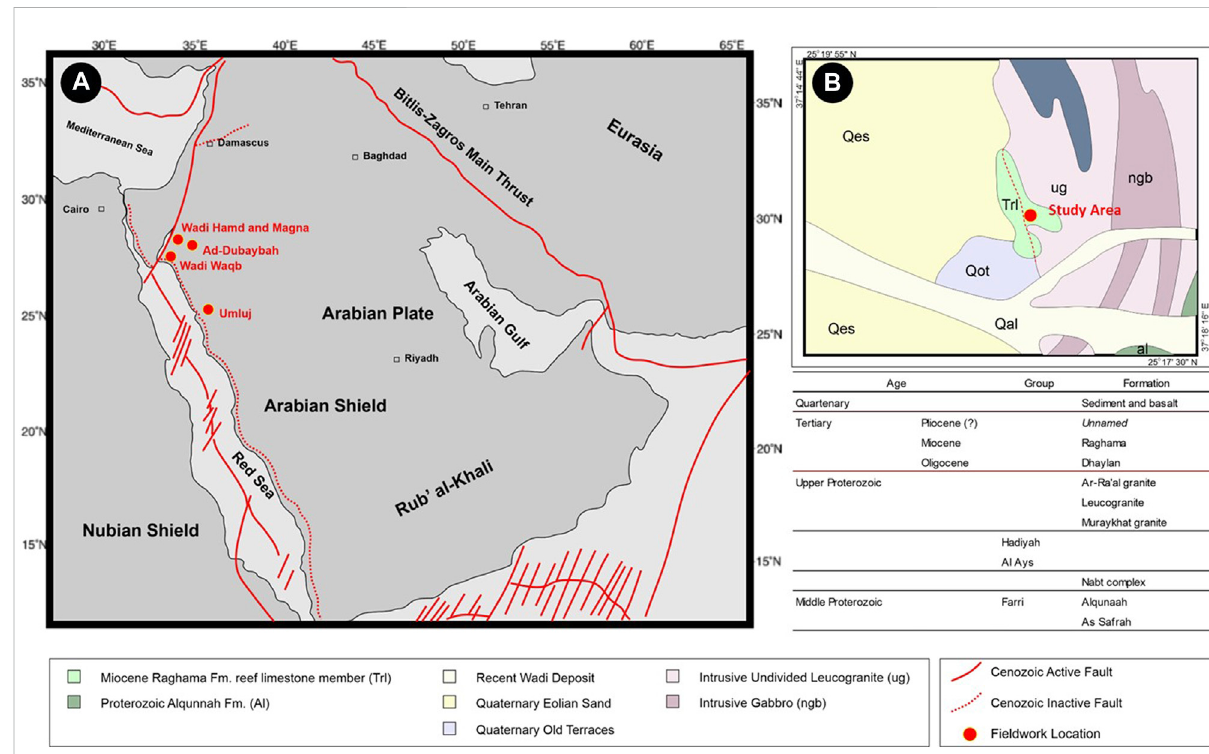
FIGURE 1 Map of the study area. (A) Regional tectonic of the Saudi Arabian Plate. The red dots are Umm Luj ’ s recent study area and three previous study areas:Wadi HamdandMagna,Ad-Dubaybah,andWadi Waqb(Al-Ramadan,2017;Al-Ramadanetal.,2019)fromthenorthtothesouth,respectively. TheredboxintheUmmLujindicatesthestudyarea. (B) GeologicalmapoftheUmmLujstudyareaandtableofthelithostratigraphicunitofthestudy area [modi fi ed according to Pellaton